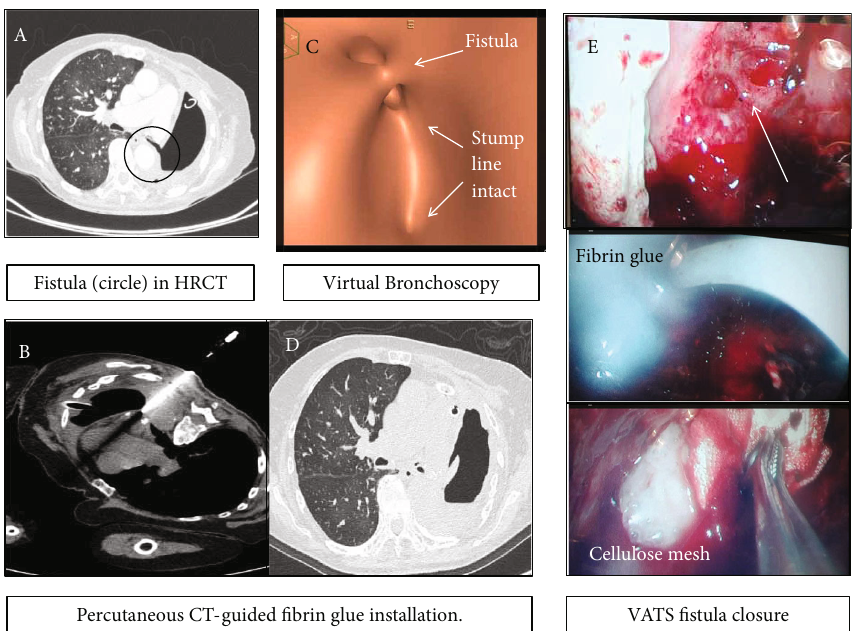
Figure 1: (a) The narrow fi stula tract is the identi fi able target for glue obliteration. (b) Percutaneous CT fi brin instillation. (c) Virtual bronchoscopy is useful for the estimation of the problem. (d) Airtight obliterated fi stula after the water test. (e) Thoracoscopic images of a chronic bronchopleural fi